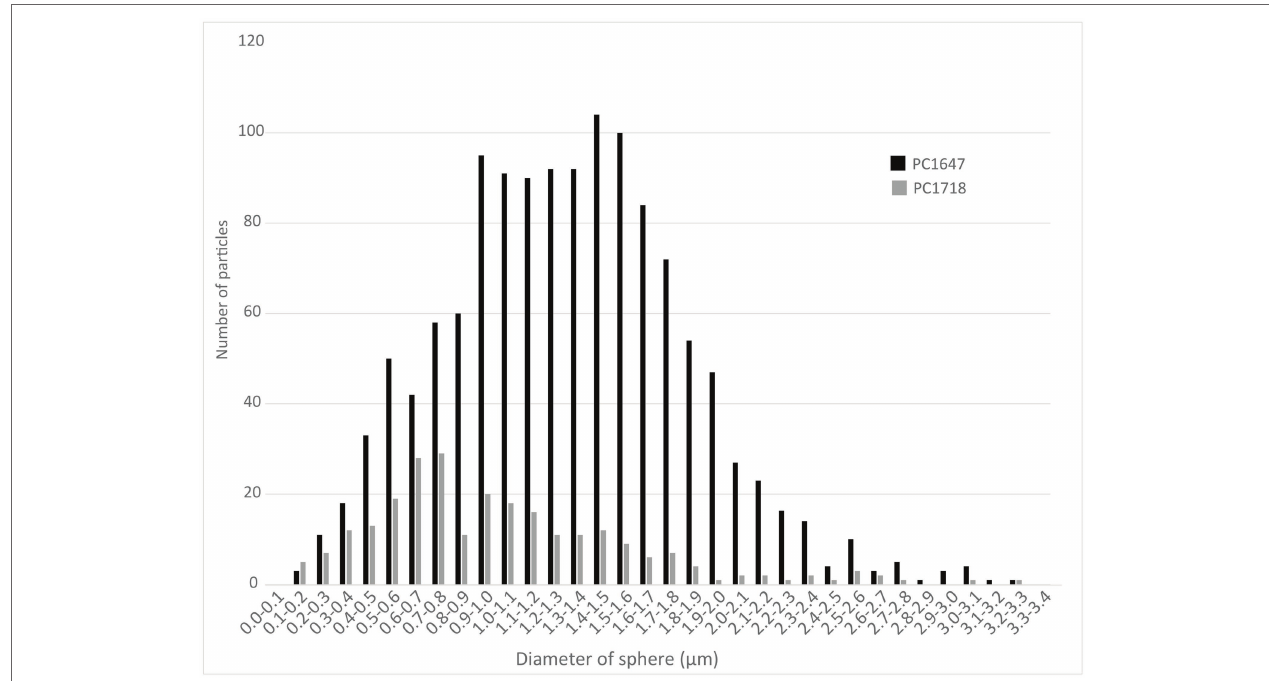
FIGURE 3 | Histograms depicting the size distributions of spherical S(0) particles in the PC1647 and PC1718 biofilm